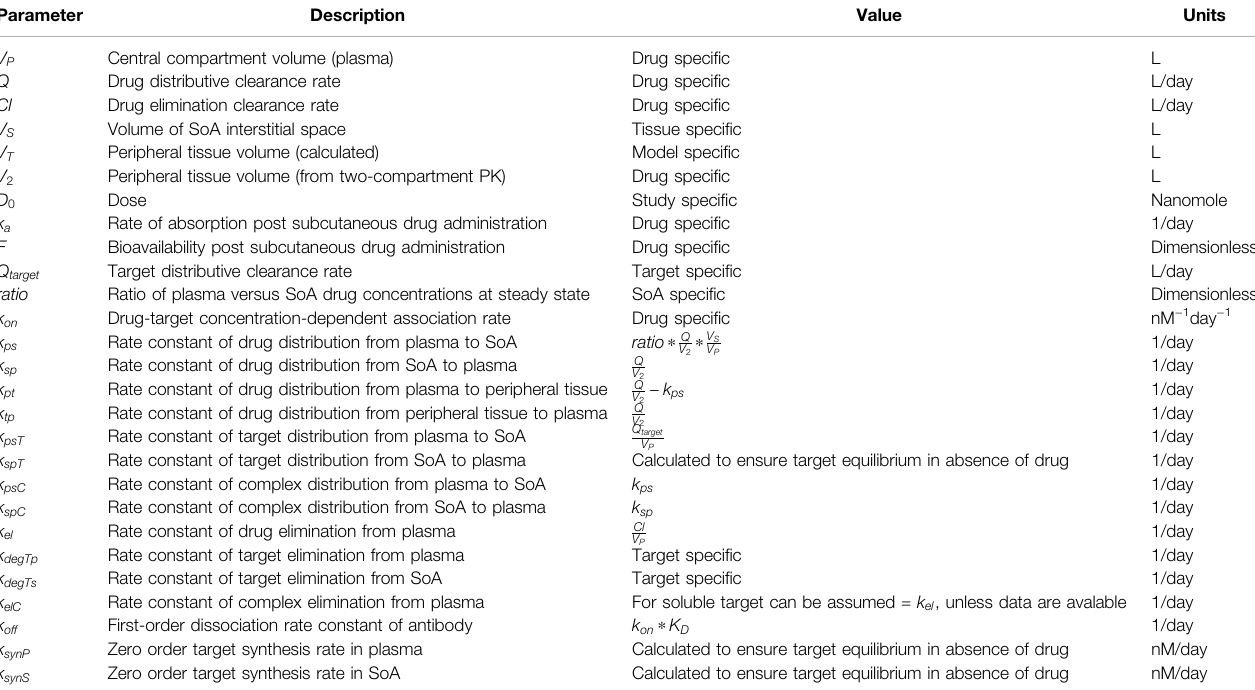
TABLE 1 | De fi nition of parameters used in SoA model.